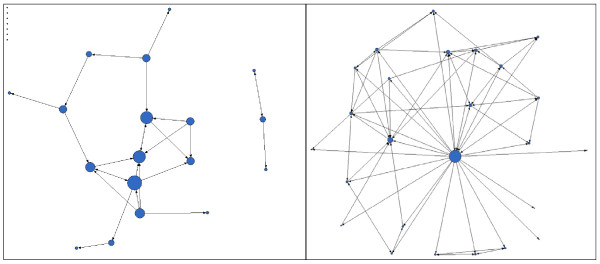
MHA trainee network before the program started (left) and at year 1 (right), n = 25. Key: Circular nodes represent trainees. Node size represents degree (number of connections); nodes in upper left corner of diagram on left represent isolates (individuals who did not report any connections).